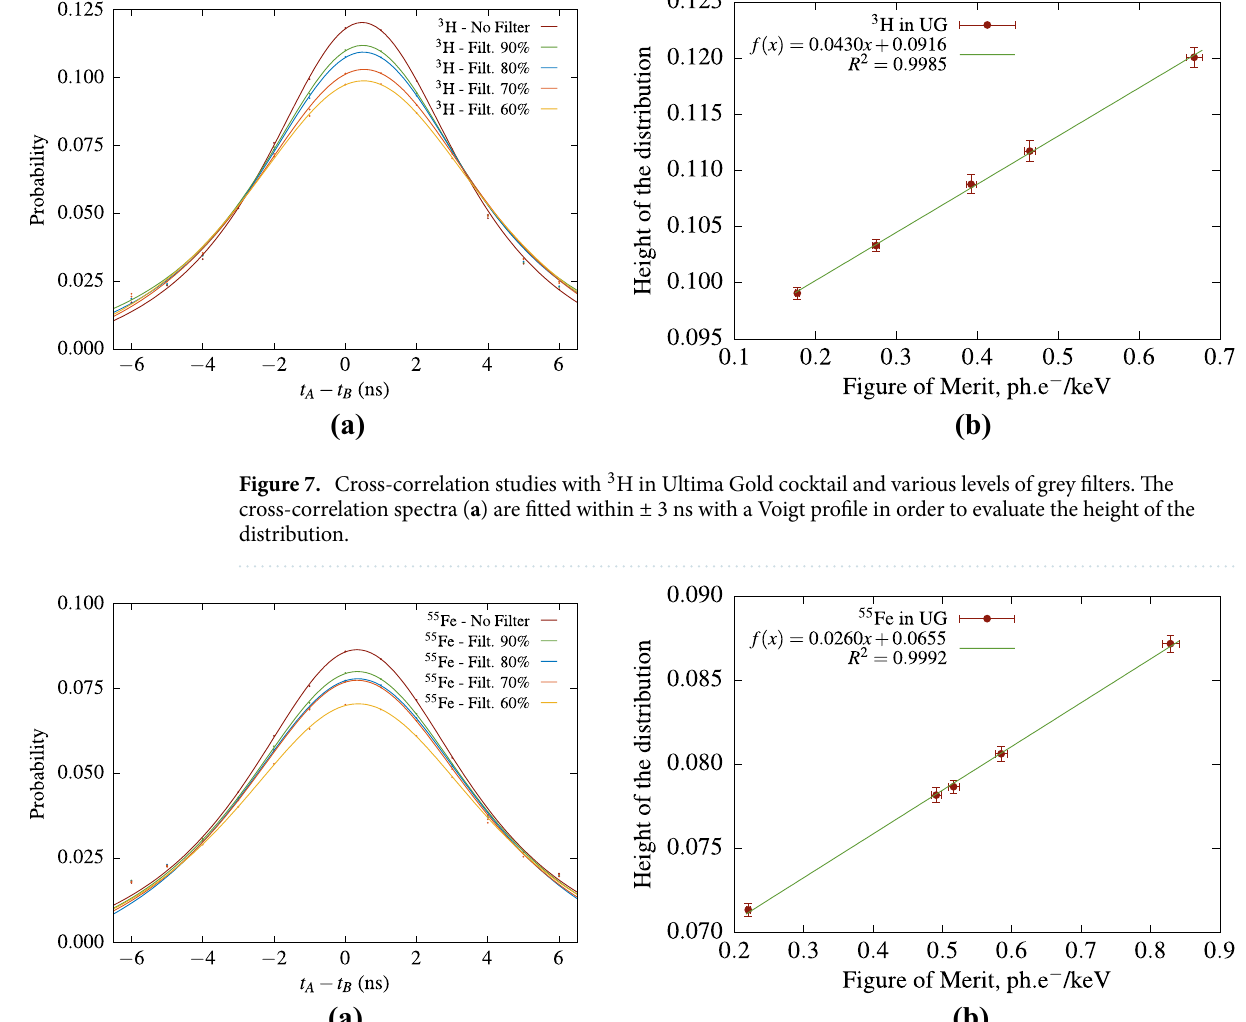
Figure 8. Cross-correlation studies with cross-correlation spectra ( a ) are fitted within ± 3 ns with a Voigt profile in order to evaluate the height of the